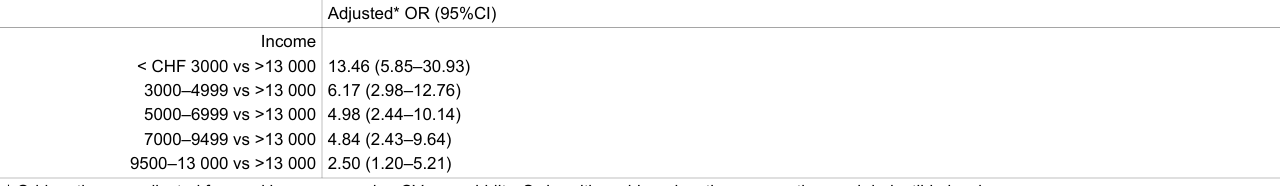
Table 1: Adjusted odds ratios (OR) and 95% confidence intervals (CI) for risk of health care renunciation for economic reasons by income during the previous 12 months among a representative sample of 35- to 74-year-old citizens of the Canton of Geneva, Switzerland (2008–9). Adjusted* OR